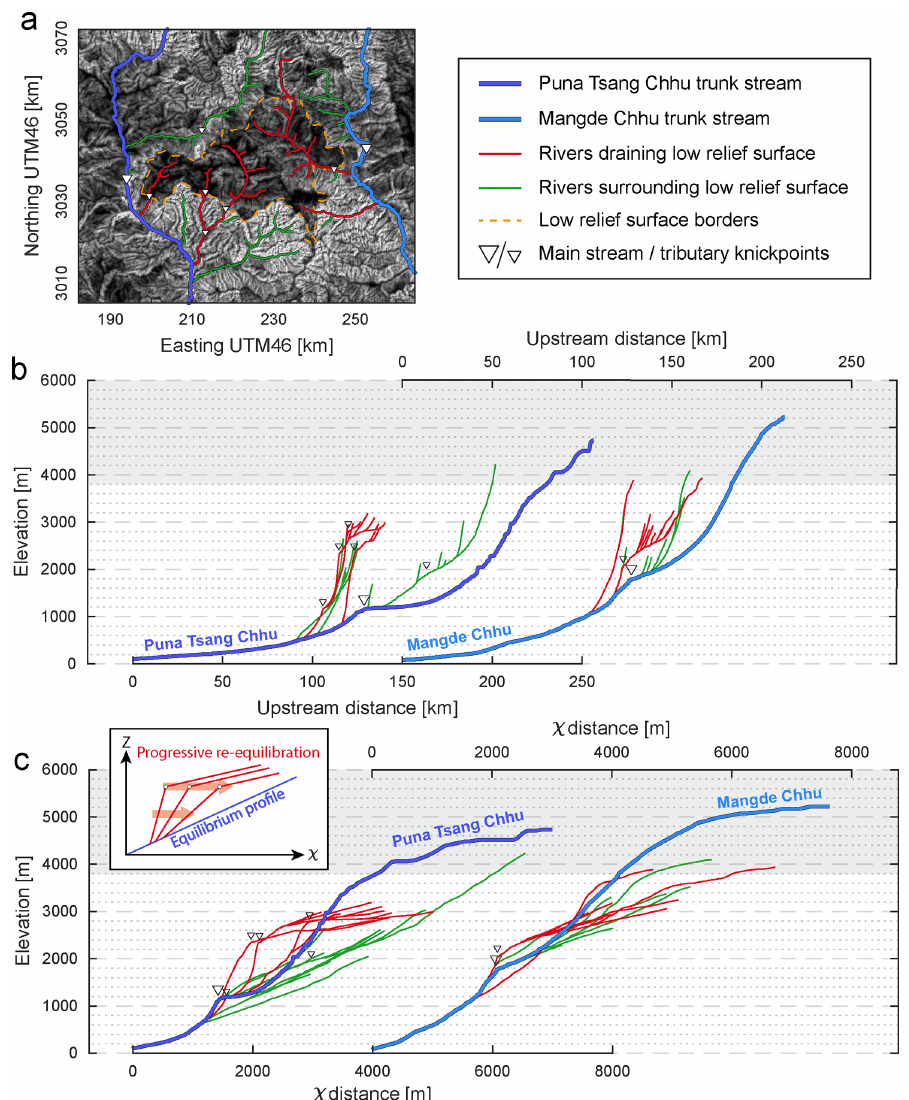
Figure 8. Longitudinal and transformed river profiles around and within the Phobjikha high-altitude low-relief surface, following the ap- proach of Yang et al. (2015). Comparable results are verified for the Yarab surface (Fig. S8 in the Supplement). (a) Map of topographic relief of the Phobjikha area (see Fig. 1c for location), with a moving window of 500m (scale bar as in Fig. 9); the identified low-relief region is delimited by the orange dashed line. Major knickpoints are reported with inversed triangles. Tributaries of the Puna Tsang Chhu (west) and Mangde Chhu (east) trunk streams are color-coded, according to whether they drain the low-relief area (red) or are external to it (green). (b) Longitudinal river profiles of the Puna Tsang Chhu and Mangde Chhu, with main tributaries draining (red) or external (green) to the low-relief Phobjikha area. (c) Transformed river profiles of the same rivers. Tributaries draining the low-relief area (red) plot above the main trunk streams as is observed in the case of area gain by river capture (Fig. 4c). None of these profiles are concordant, indicating that these captures are not coeval and do not follow a coherent wave of incision propagating upstream. It should be noted that the higher the χ position of the knickpoints of the internal streams, the lower the steepness of the pirate streams downstream of their knickpoint. This is particularly illustrated by the Puna Tsang Chhu tributaries and is interpreted as reflecting progressive re-equilibration of pirate streams toward an equilibrium profile after capture (inset). Tributaries external to the low-relief area (green) are locally overall colinear with their main trunk stream, even though they gain drainage area by progressive divide migration (Fig.